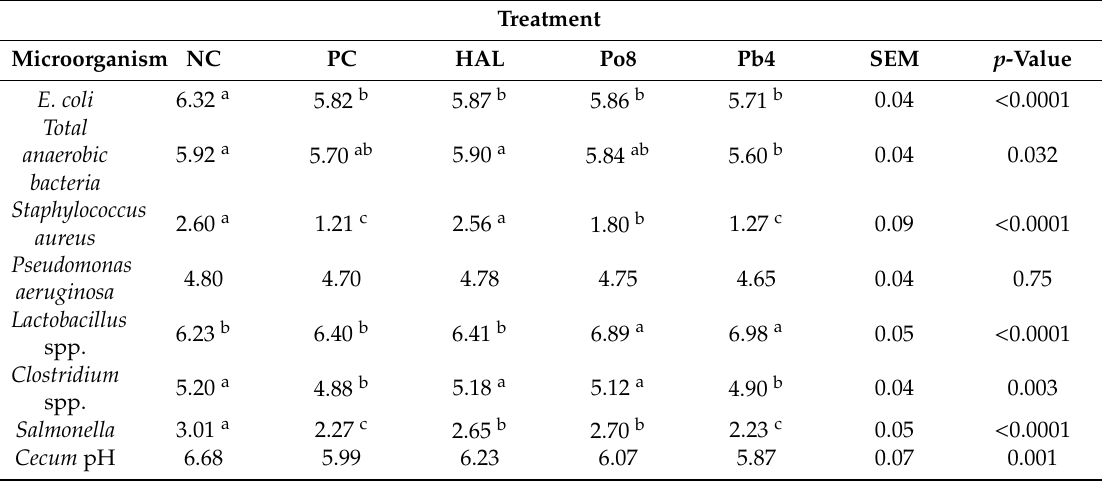
Table 5. Cecal microbiota composition of broilers supplemented with phytobiotics, HAL and AGPs.